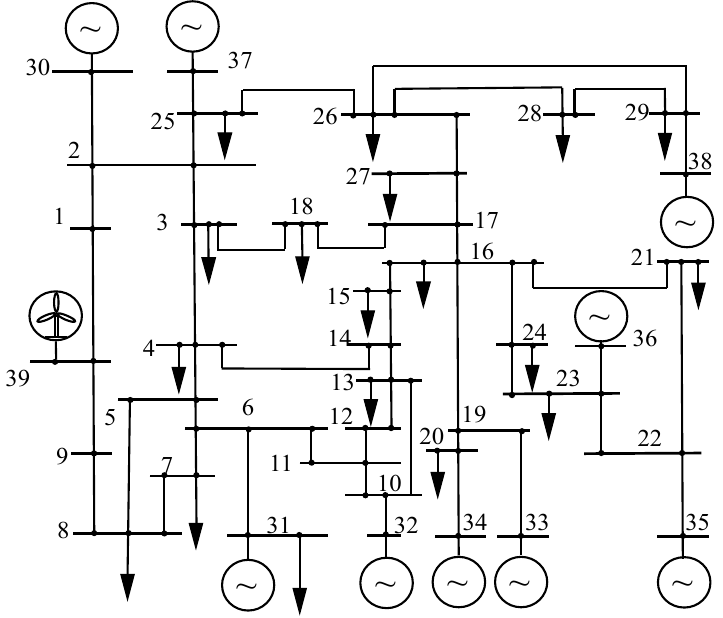
Figure 6. Modified IEEE 39 bus system.